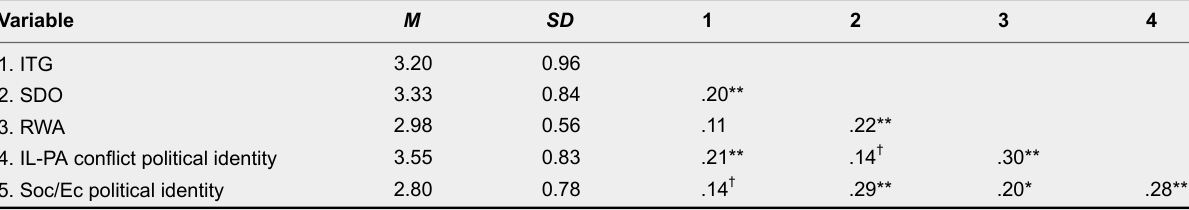
Means, Standard Deviations and Intercorrelations for All Study 3